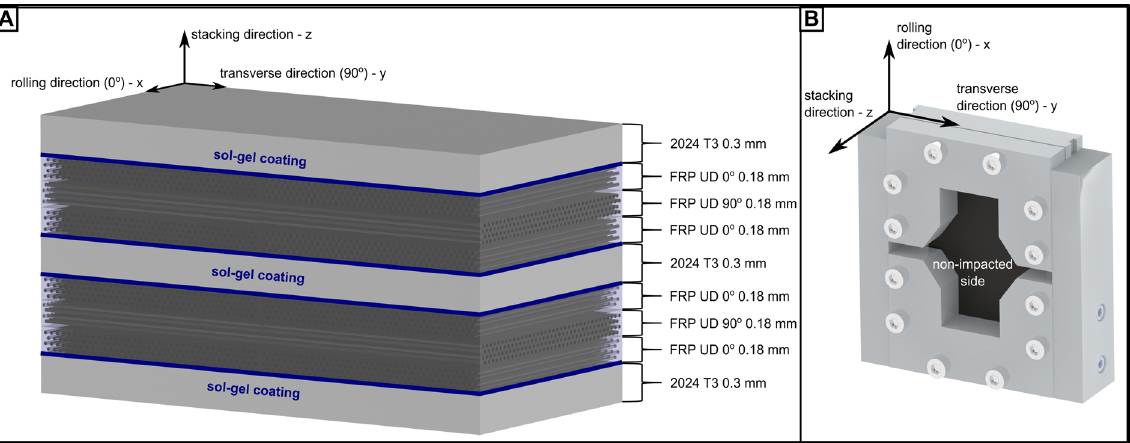
Figure 1. The structure of the studied FMLs for CARALL ( A ) and scheme of rig used for CAI test ( B ). Table 1. Designation of FML plates prepared for LVI and CAI